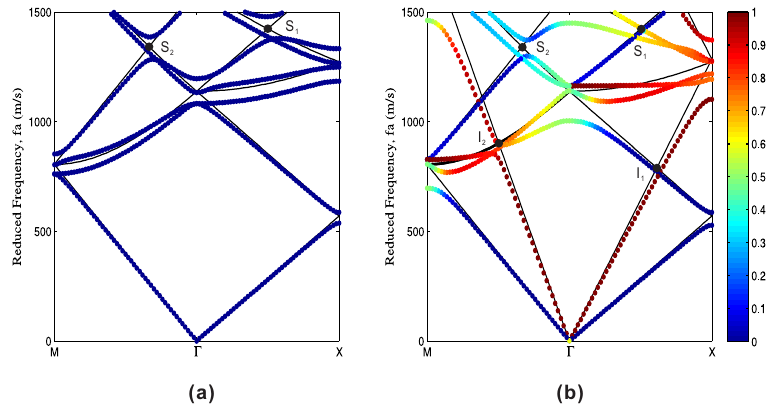
Figure 6. Band structures for ( a ) the out-of-plane polarized waves and ( b ) the in-plane polarized waves of epoxy with air holes ( d / a = 0.2). The color scale represents the polarization amount in the propagation direction, from 0 (shear) to 1 (longitudinal). Solid lines correspond to the empty lattice